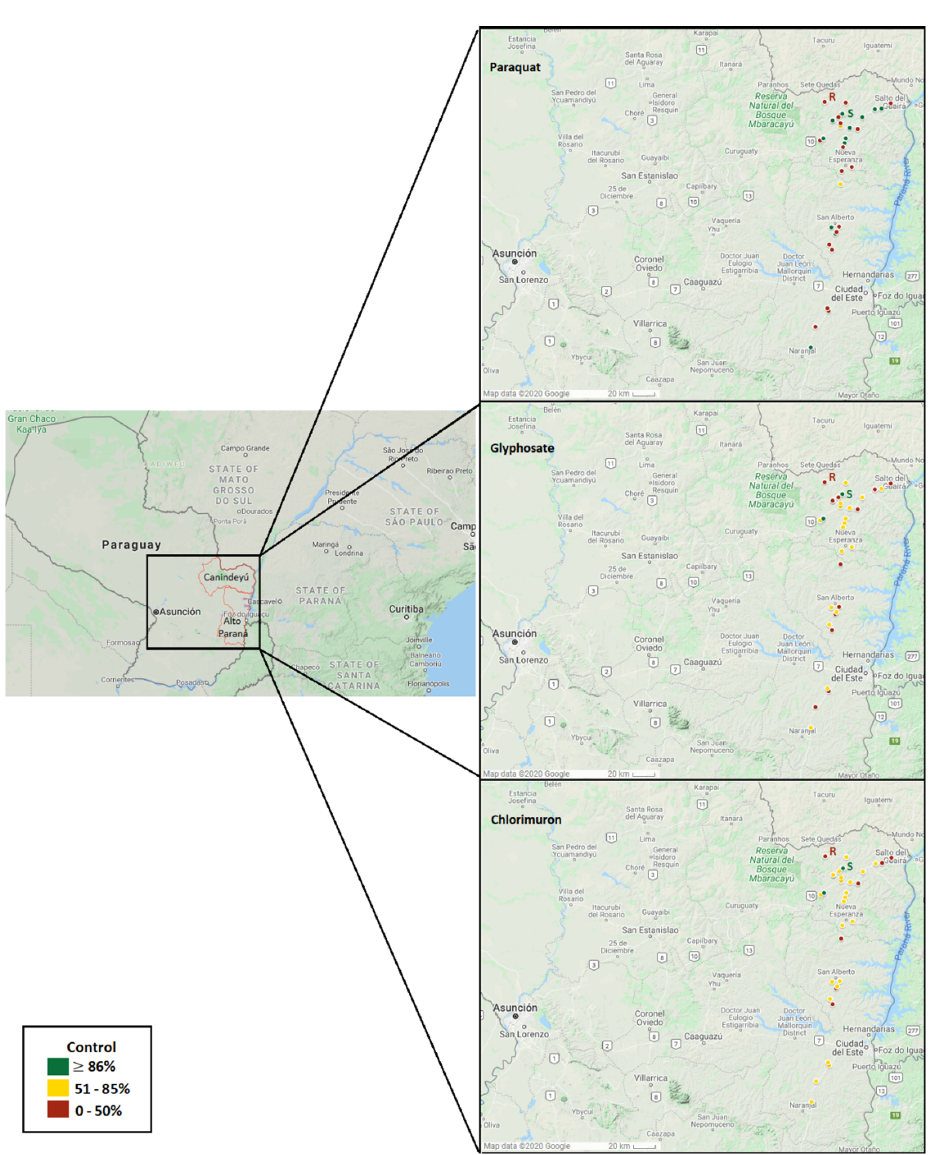
Figure 1. The geographic distribution of C. sumatrensis collection points with suspected resistance to herbicides, with respective effectiveness in the control. Canindeyú and Alto Paraná, Paraguay, 2017/18, season. R: site 27—resistant to paraquat, glyphosate, and chlorimuron; S: site 33 — susceptible.